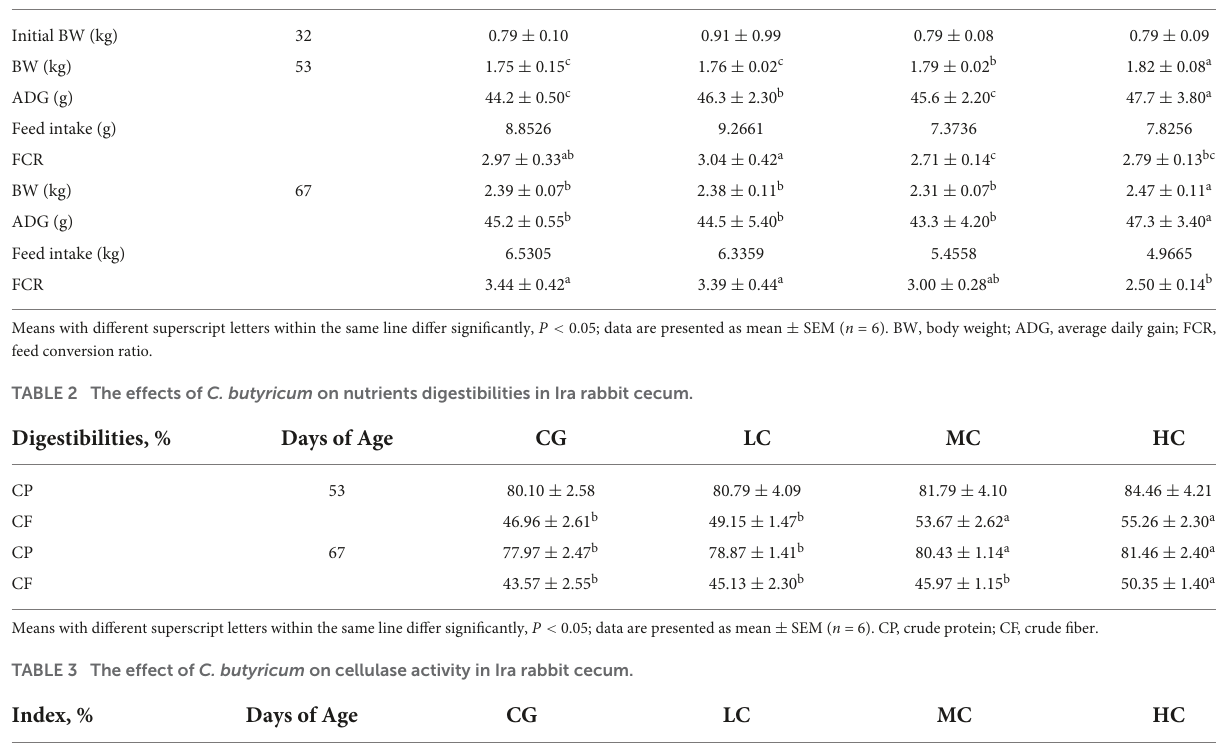
TABLE 1 The effects of C. butyricum on the growth performance of Ira rabbits. Indexes